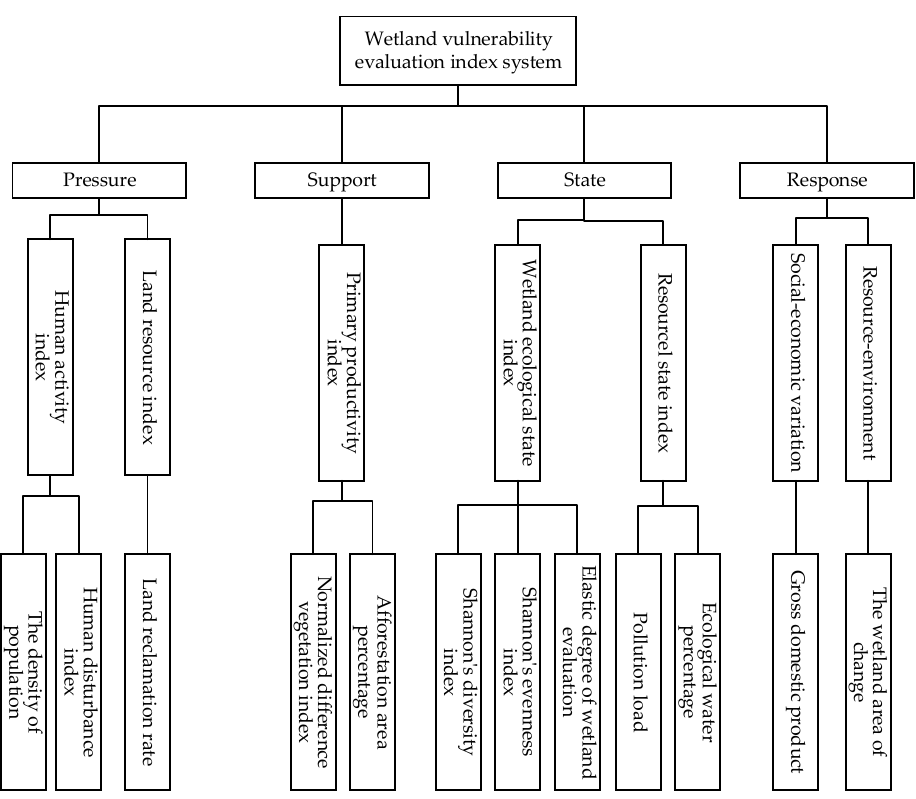
Figure 2. Wetland vulnerability assessment indicator system [46].